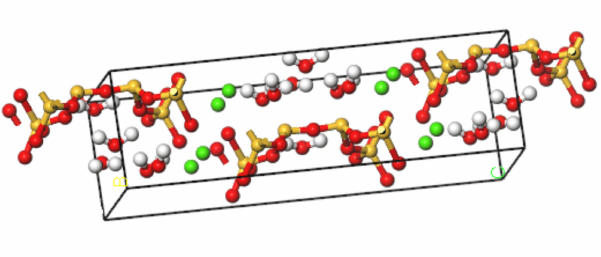
Figure 1. Molecular modeling of C-S-H (yellow balls are Si atoms, green balls are Ca atoms, red balls are O atoms, white balls are H atoms).